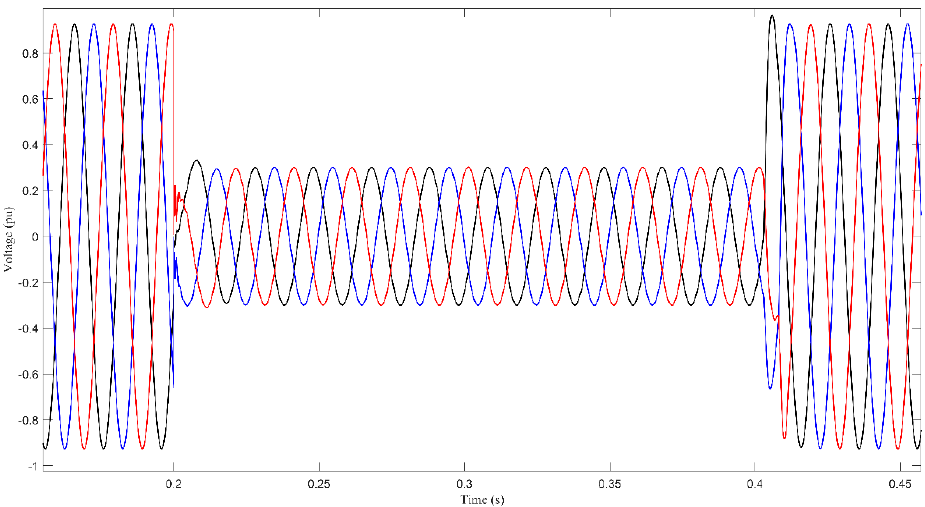
Figure 10. The voltage waveform of the 35-kV bus.